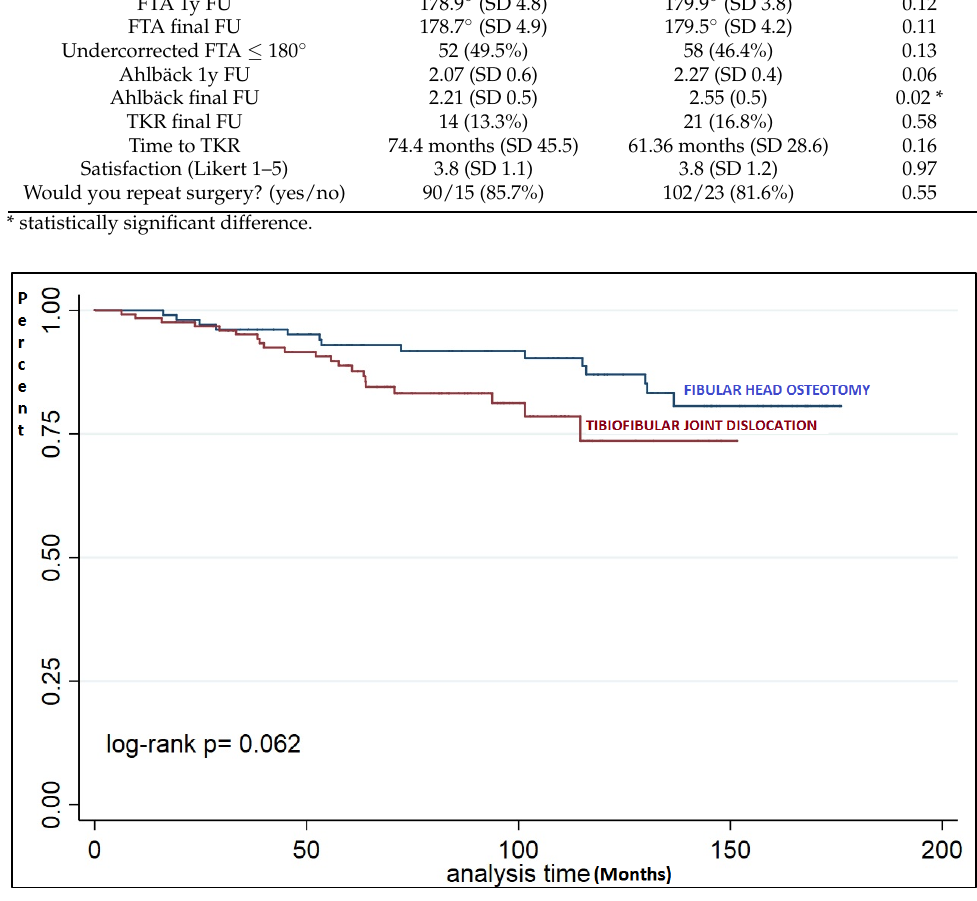
5 of 10 Table 3. Results summary in function of the FHO or TFJD group: clinical results (KSS R and KSS R),